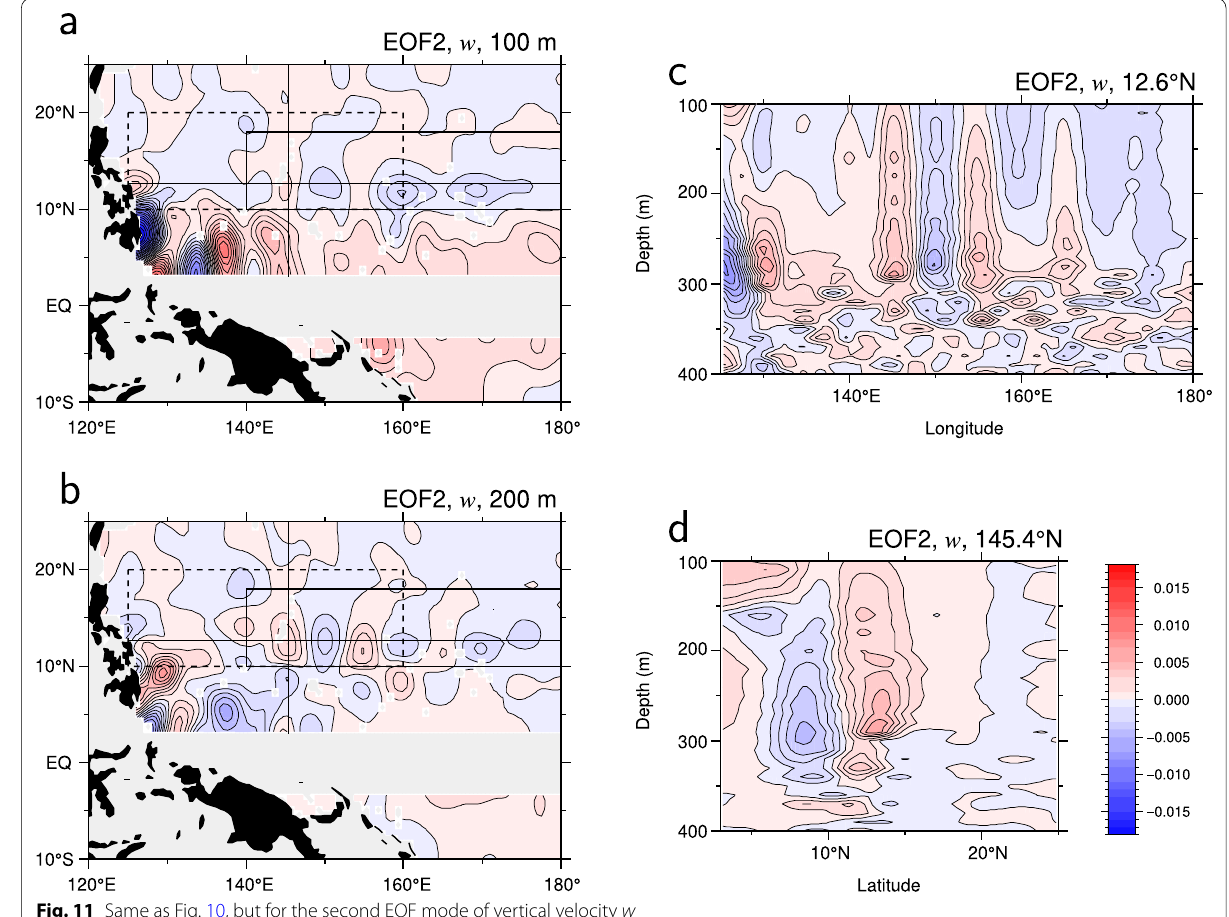
Fig. 11 Same as Fig. 10, but for the second EOF mode of vertical velocity